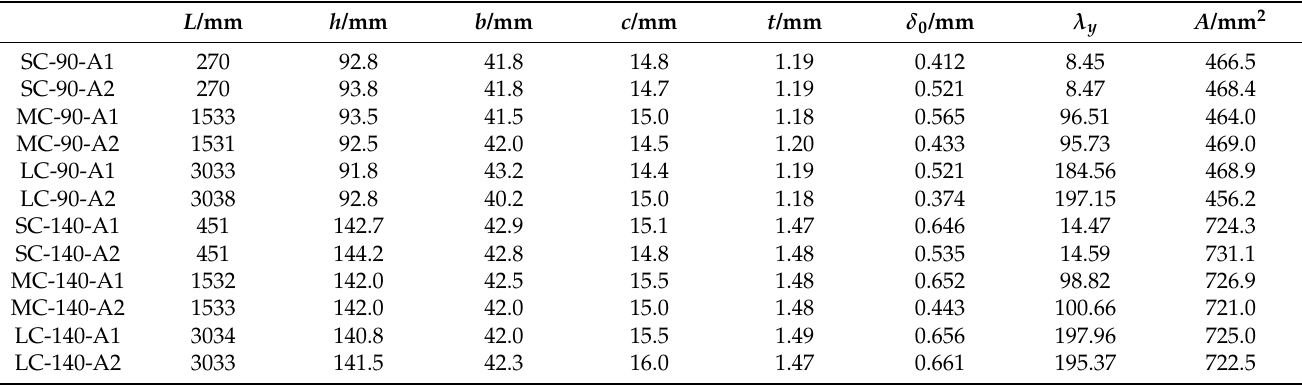
Table 1. Parameters of the C-steel combined I-section columns in Ref